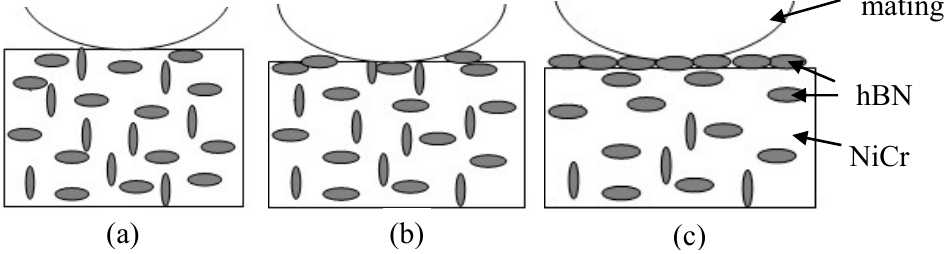
Figure 4. Schematic of the formation of solid lubricating film for NiCr/hBN composite: ( a ) pre-friction stage, ( b ) initial friction stage; and ( c ) stable friction stage.